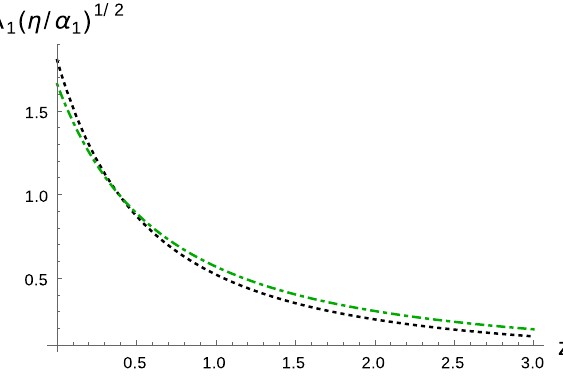
Fig. 4 Theevolutionofthemodulatedtemporalcomponentofthedark energy vector (cid:2) 0 as a function of the redshift z for two non-vanishing values for the constant η = − 0 . 02 (dot-dashed) and η = 0 . 1 (dotted). We use the best fit values for the model parameters presented in Table